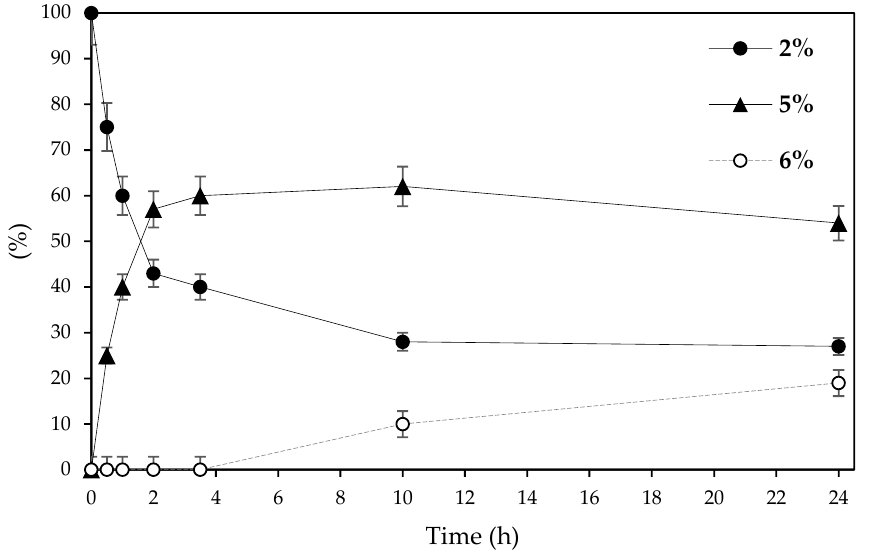
Figure 2. Time course of the N-435 ® -catalyzed synthesis of 6- O -(R)-3-hydroxybutyryl ascorbic acid 5 performed with 2 equivalents of 4 . The values are the means of three independent experiments.